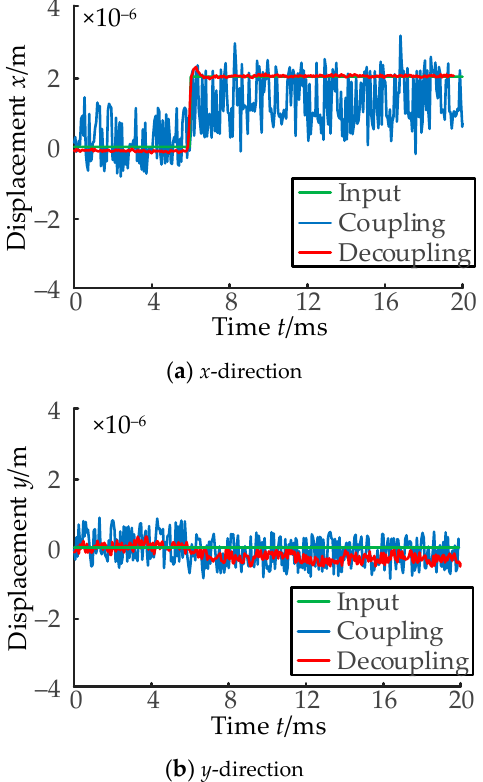
Figure 23. Displacement under step signal in channel x.